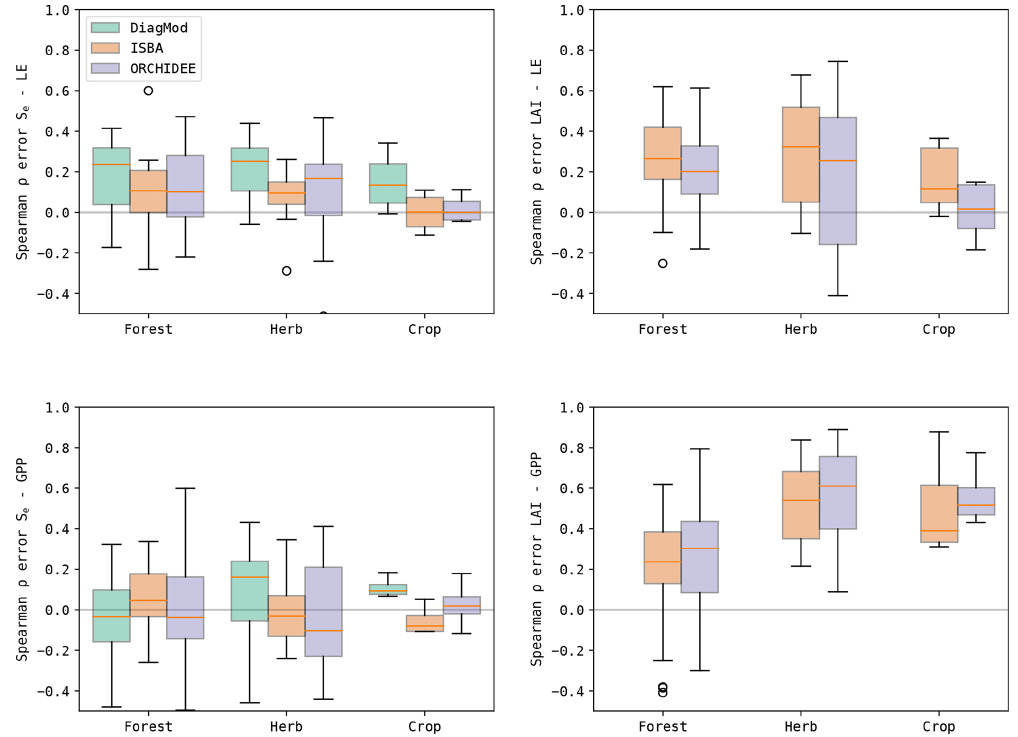
Figure 14. Boxplots of the Spearman correlation between the errors in the state variables ( S e and LAI) and the fluxes ( LE and GPP) at the test sites, grouped per dominant land